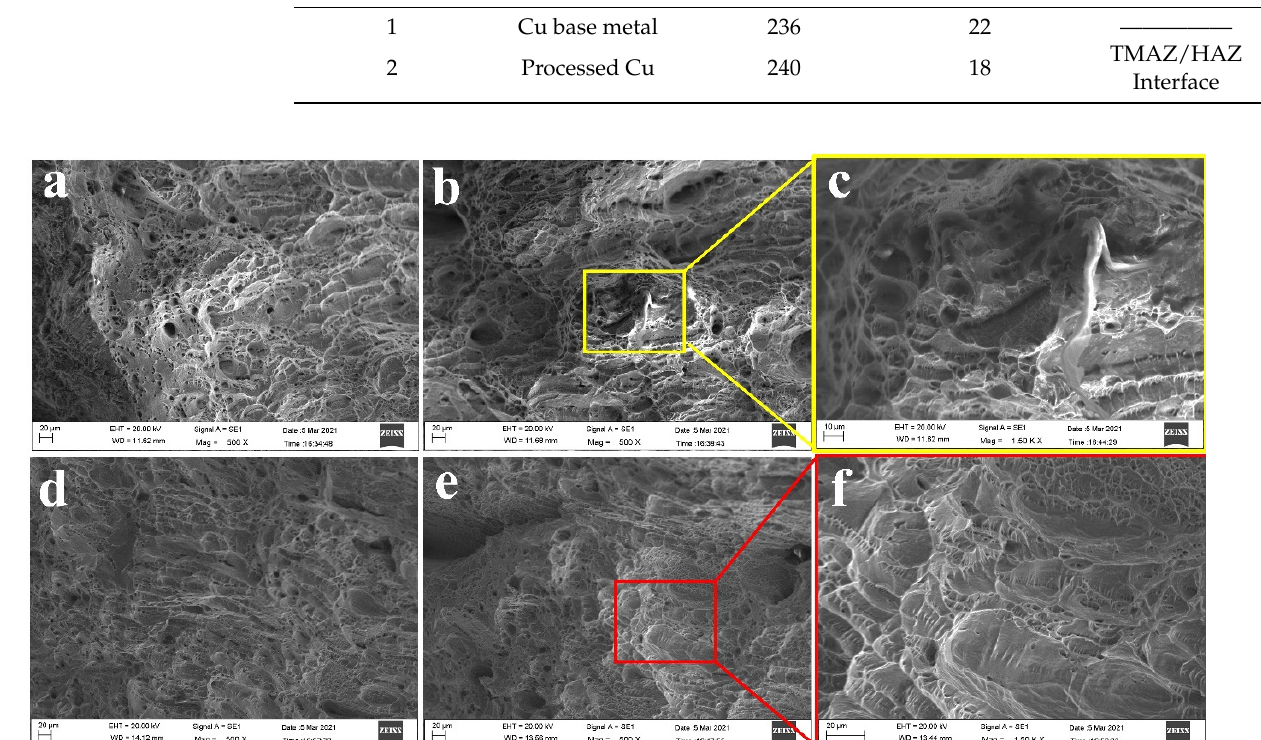
Figure 9. Fractographic analysis of tensile specimen corresponding to ( a )–( c ) Cu base metal ( d )–( f ) Processed Cu.